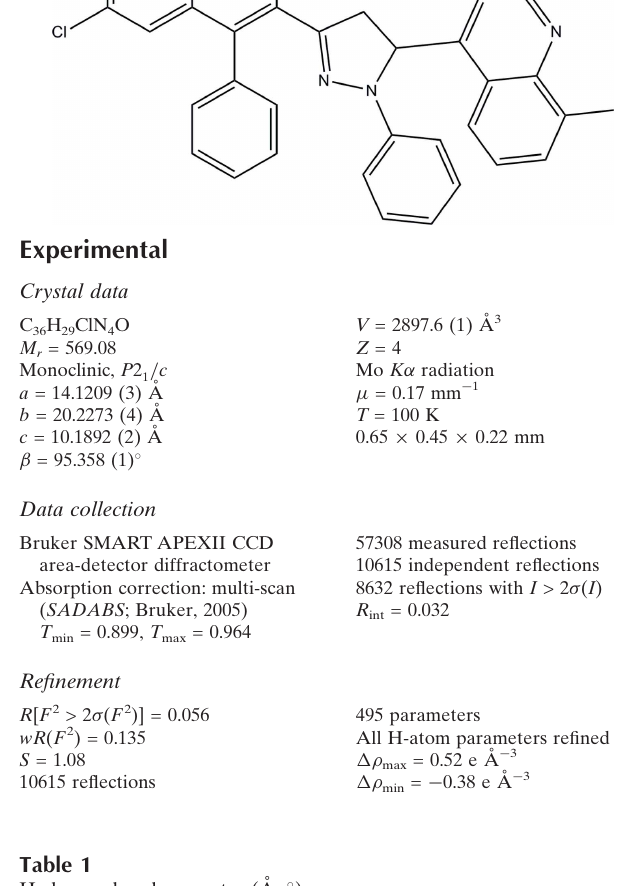
Hydrogen-bond geometry (A˚ , (cid:2)